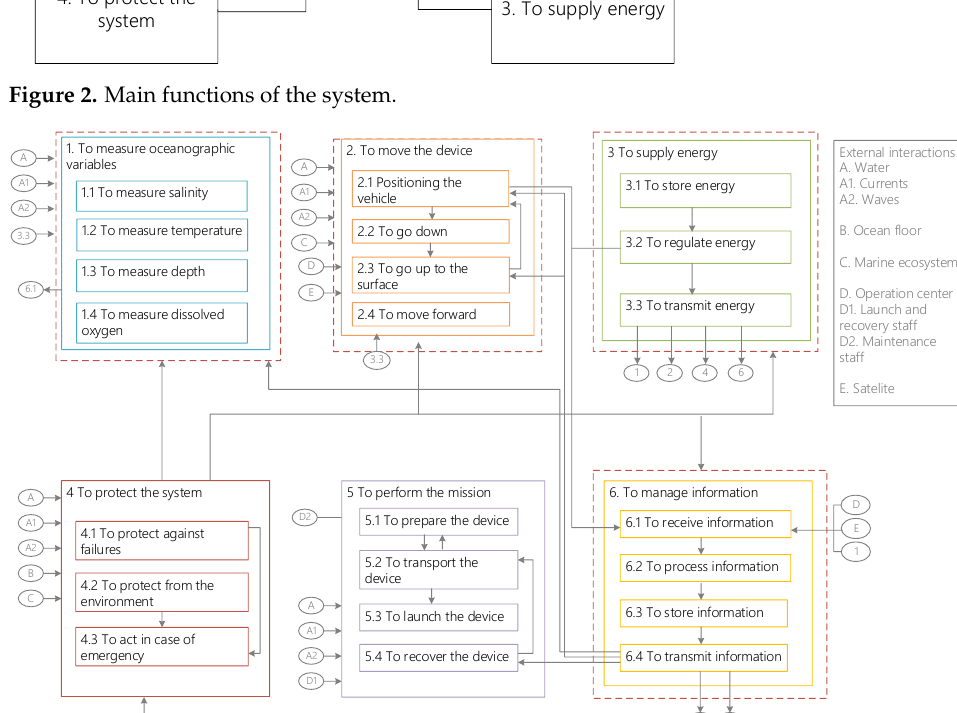
Figure 3. Functional architecture. Main functions are divided into subfunctions. Arrows that enter into a function indicate that other functions affect this function. Arrows that go out of a function indicate that this function affects other